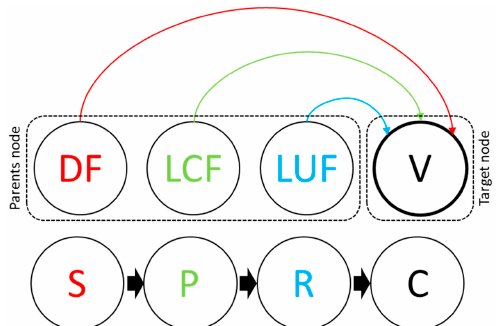
Figure 5. Bayesian belief network (BBN) conceptual model and associated source–pathway–receptor– consequence (SPRC_chain applied to the vulnerability assessment [78,79]. BBN conceptual model indicating that nodes driver factors (DFs), land cover factors (LCFs), and land use factors (LUFs) have a common e ff ect on node V. This implies a conditional dependence between nodes DF, LCF, and LCF that are in e ff ect competing to explain V [92]. Solid line circle indicates parent nodes, and the colored solid arcs indicate that all variables of the parent category influence all variables of the child category; thick line circle represents target